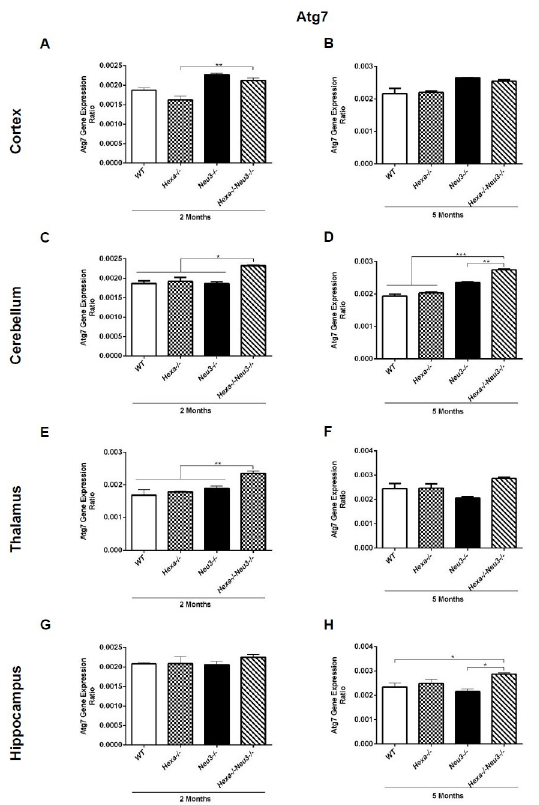
Fig 3. Atg7 gene expression of the levels of the cortex (A, B), cerebellum (C, D), thalamus (E, F), and hippocampus (G, H) of 2- and 5-month-old WT , Hexa-/- , Neu3-/- , Hexa-/-Neu3-/- mice. Expression ratios were calculated by the Δ CT method and percent ratios were represented. One-way ANOVA analysis was used to determine p-values via GraphPad. Data are reported as mean ± SEM (n = 3; � p < 0,05, �� p < 0,025, ��� p <